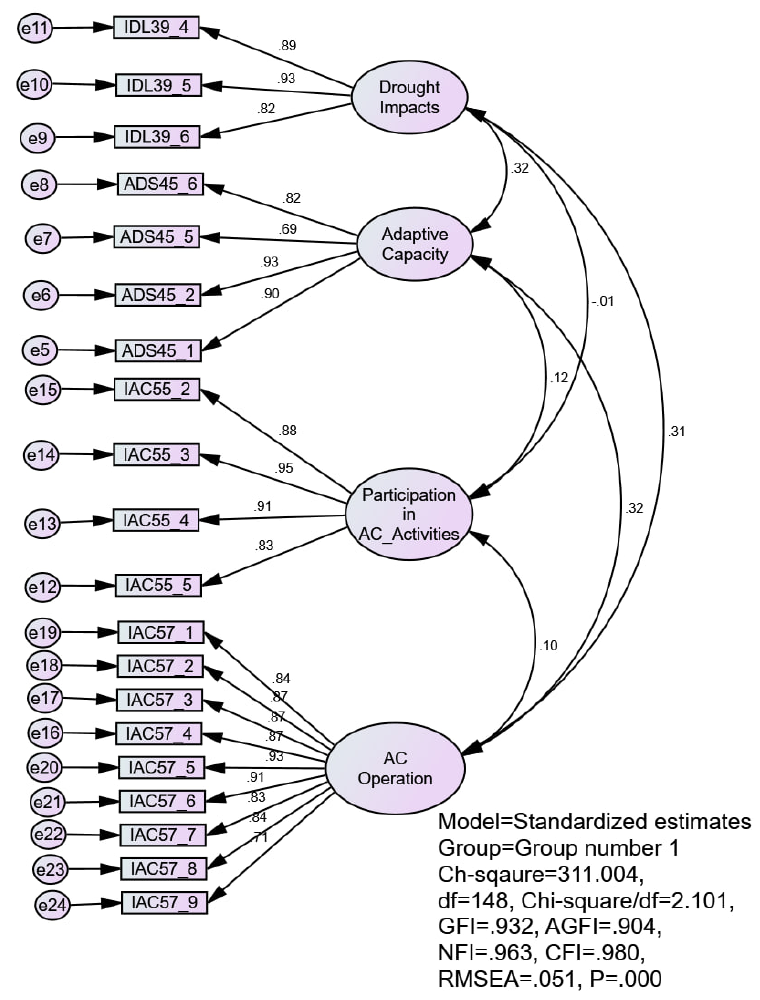
Figure 1. The results of the second-order factor model and overall model.